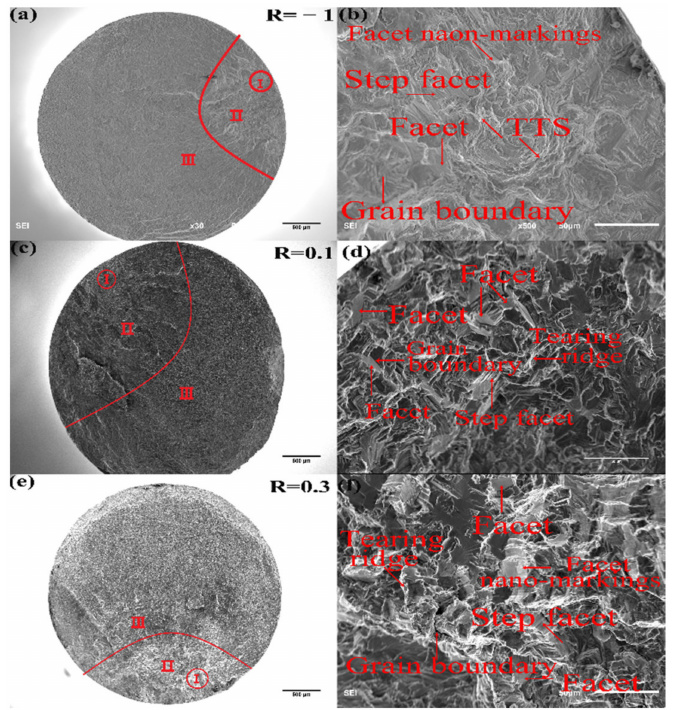
Figure 8. Fracture surface of specimens with subsurface crack initiation: ( a , b ) R = − 1, σ a = 460 MPa, N f = 1.212 × 10 7 cycles; ( c , d ) R = 0.1, σ a = 170 MPa, N f = 6.402 × 10 7 cycles; ( e , f ) R = 0.3, σ a = 130 MPa, N f = 2.987 × 10 8 cycle. I, II and III indicate the region I, II and III,